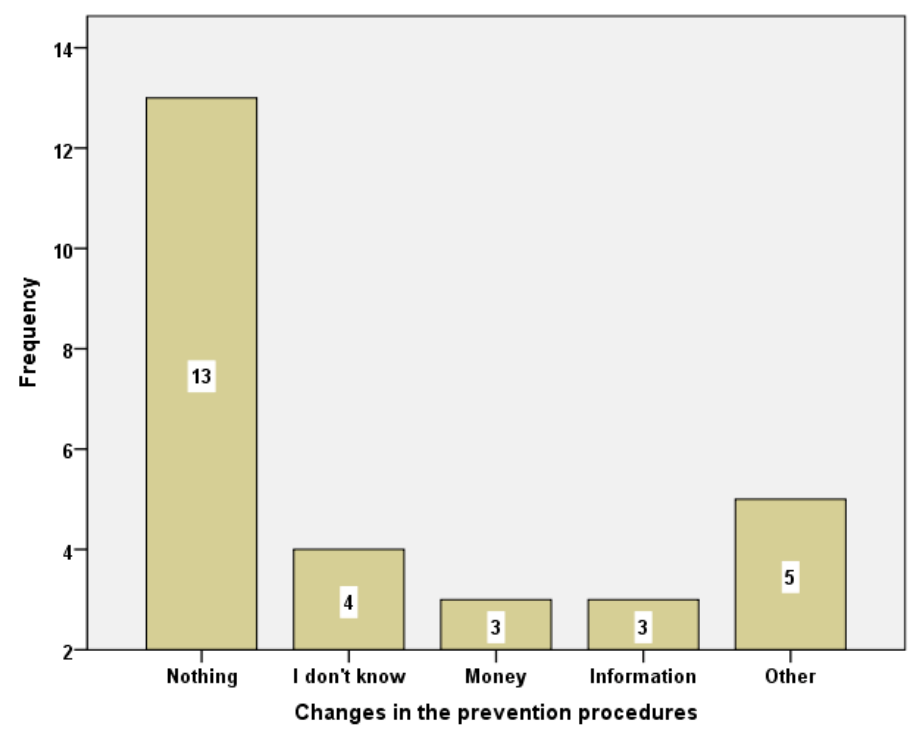
Figure 2. Changes in the prevention procedures.